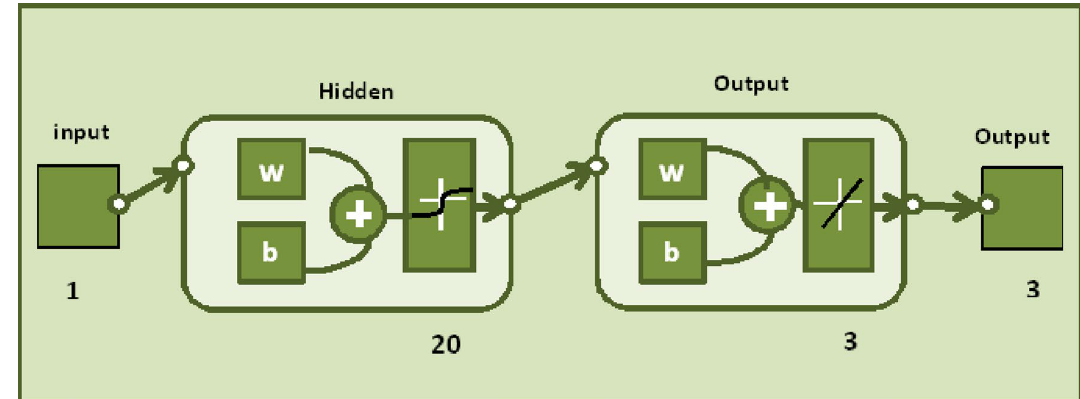
Figure 2. Networks architecture of ANNs-BRS scheme.